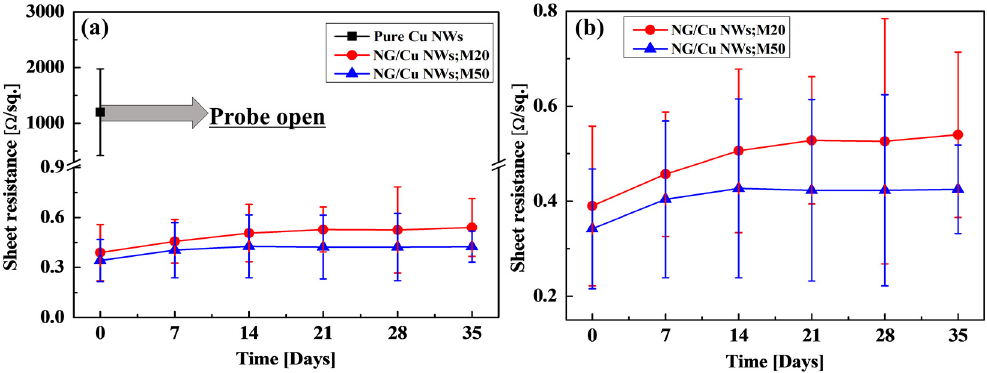
Figure 5. ( a ) Sheet resistance of the pure Cu NWs, NG / Cu NWs;M20, and NG / Cu NWs;M50 and ( b ) the enlarged sheet resistance of NG / Cu NWs;M20 and NG / Cu NWs;M50.